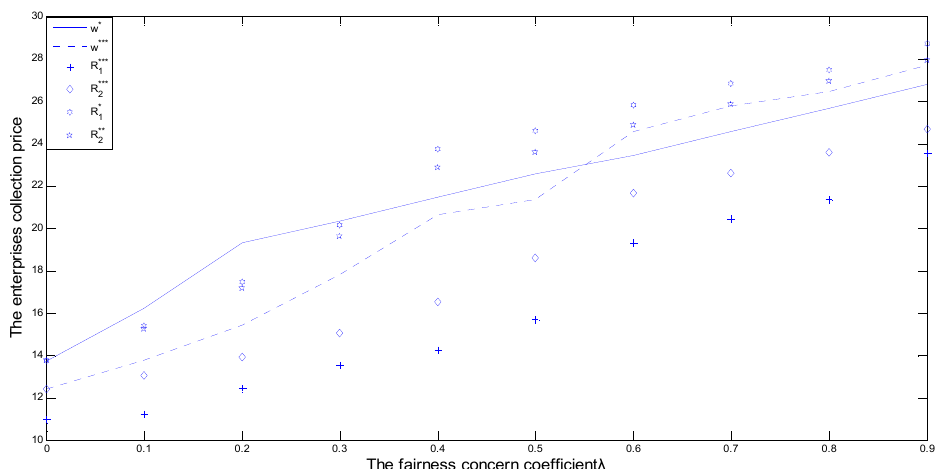
λ on the collection price